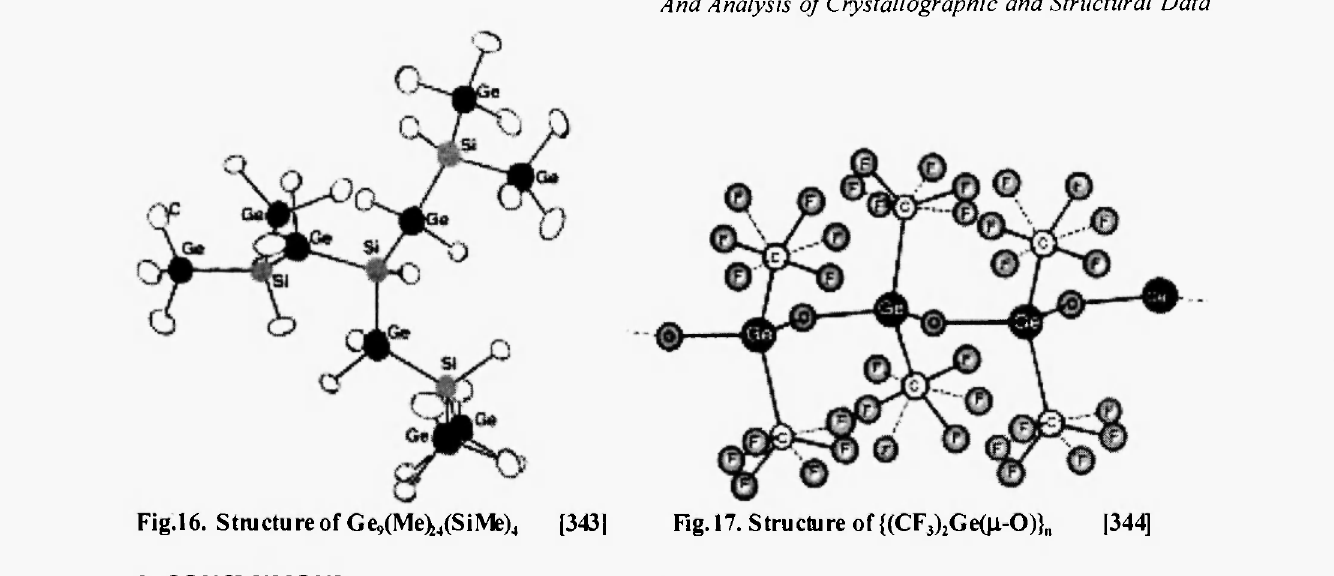
Fig.16. Structure of Ge^Mej^SiMe)., [343] Fig. 17. Structure of {(CF 3 ) 2 Ge0i-O)}„